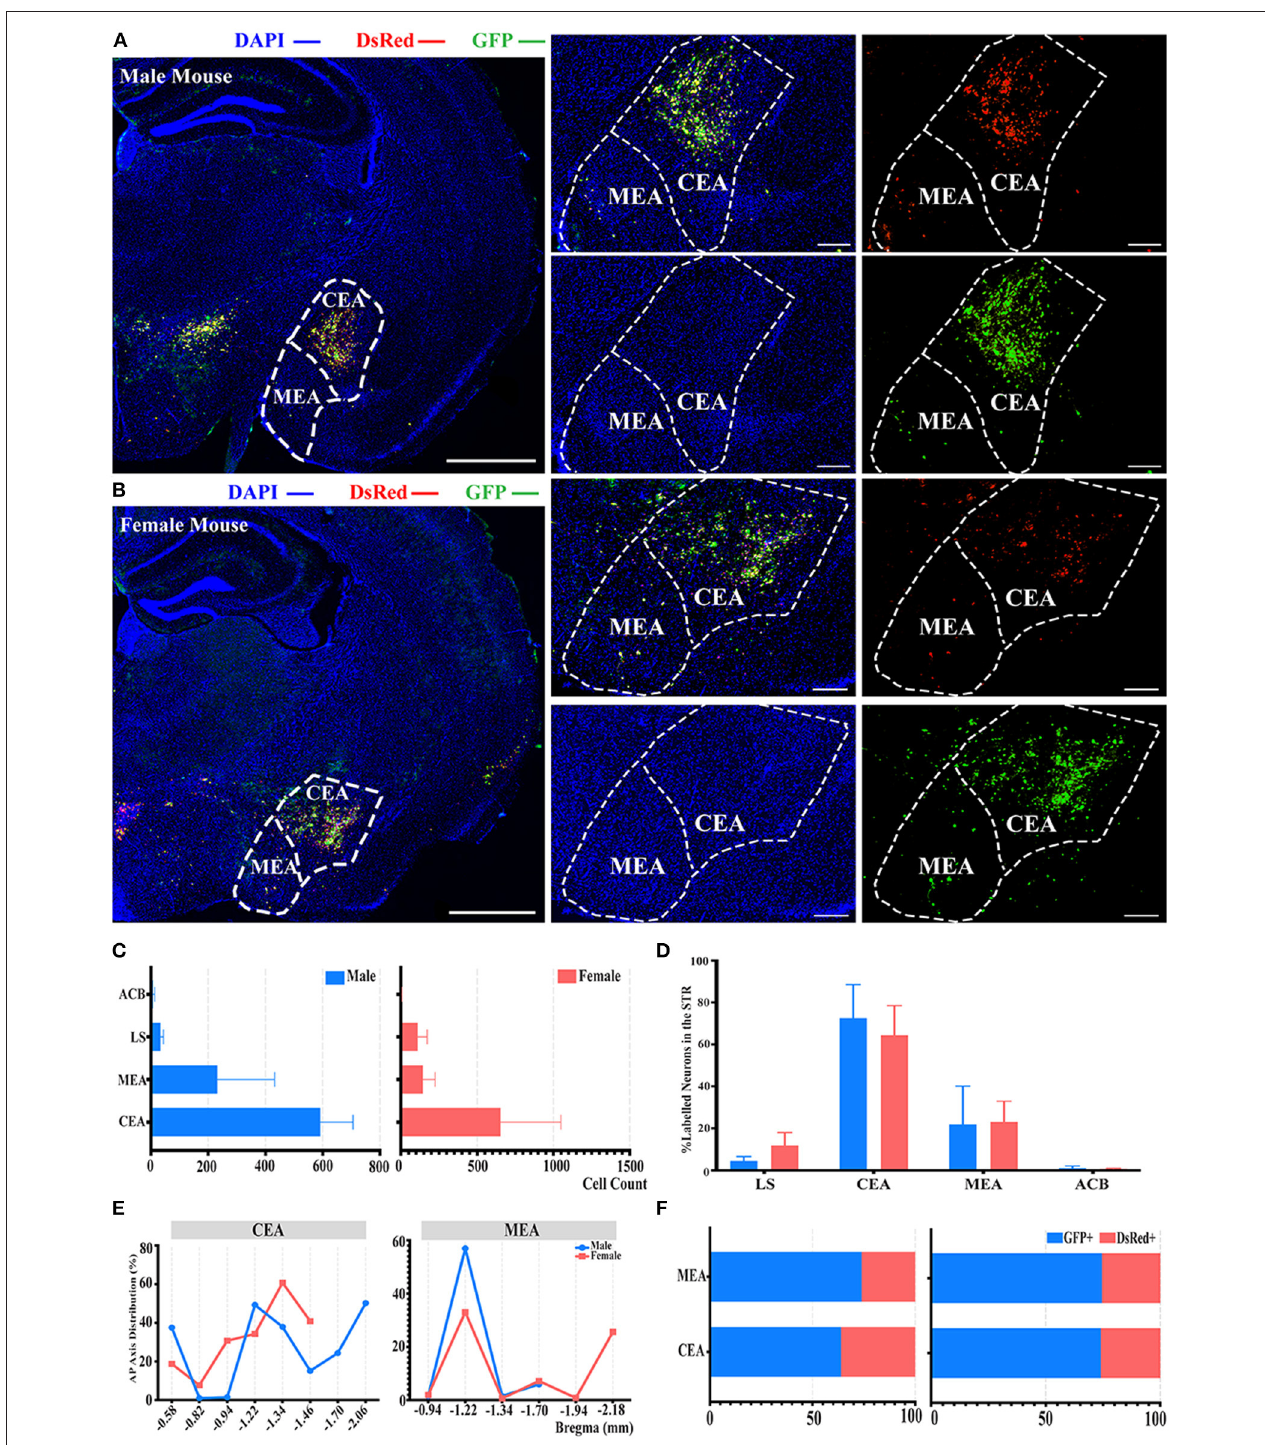
FIGURE 5 | Distribution patterns of labeled neurons in the STR. (A,B) Representative images showing labeled neurons from mouse the ipsilateral STR to the ELGs. Scale bar: 1mm (left lower magnification images), 200 µ m (right higher magnification image for male), and 500 µ m (right higher magnification image for female); ( A , male; B , female). (C) Numbers of the labeled neurons (GFP + and dsRed + ) in different subregions of STR (left, male; right, female). (D) Distribution of the labeled neurons within STR (significant difference labeled on the bar top, otherwise n.s.). (E) Distribution patterns of the labeled neurons along the AP axis in different subregions of STR. (F) Distribution of GFP + and dsRed + within subregions of STR (left, male; right, female). GFP + , PRV-GFP positive neurons; dsRed + , PRV-dsRed positive neurons. n.s., no significant difference.